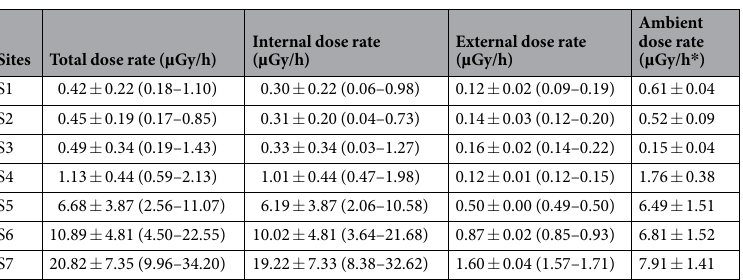
Table 1. Total, internal and external dose rates estimated in adult Hyla japonica males during the breeding season (20 June – 9 July 2012). Ambient dose rates are also indicated. Mean ± SD. Range is shown in parentheses. * Under the hypotheses of radiation coming mainly from gamma emitters, we assumed that 1 µ Sv/h = 1 µ